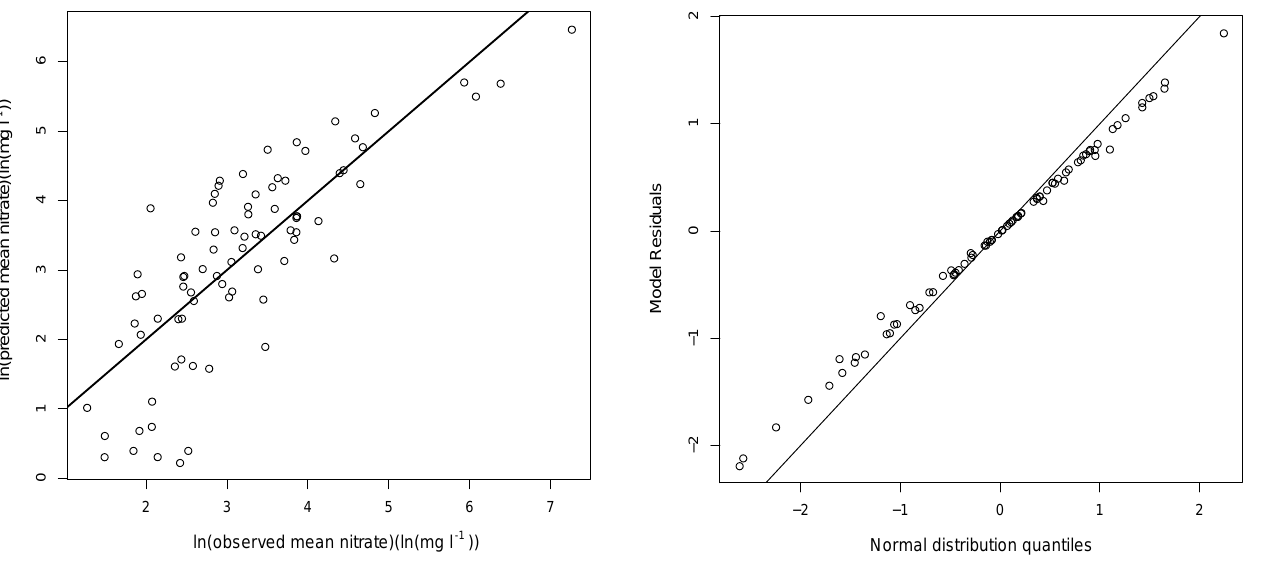
Figure 9. Predicted vs. observed mean log transformed nitrate con- centration ( R 2 = 0 . 65).